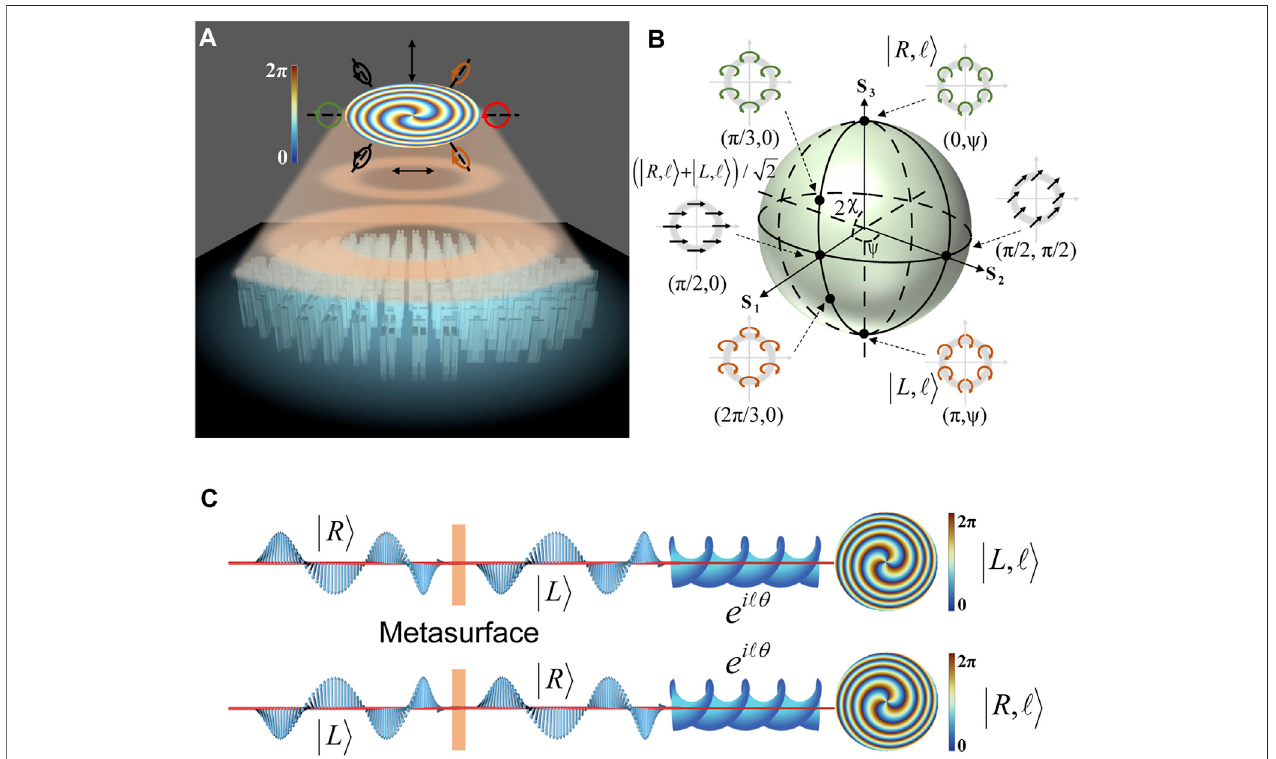
FIGURE 1 | Schematic of the fl at FOV generator. (A) Schematic of the metasurface consisting of anisotropic nanostructures for generating FOV beams with arbitrary SOP. (B) Schematic illustration of HOP ℓ , ℓ . OV beams with any scalar SOP can be obtained by superimposing the SOP corresponding to the north and south poles on the HOP sphere. (C) Spin-orbit angular momentum conversion when light passes through the proposed metasurface.